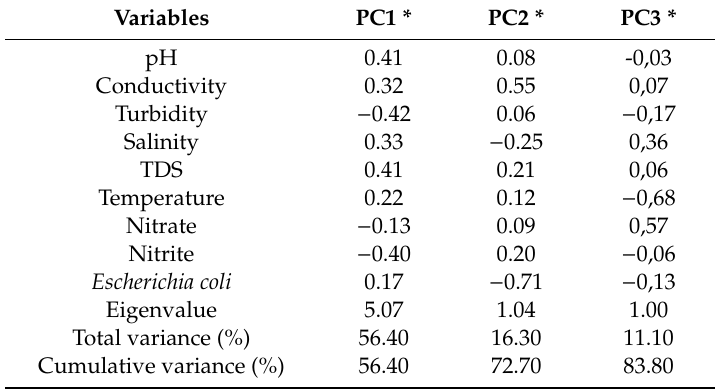
Table 3. Loadings of the variables for the first three principal components.